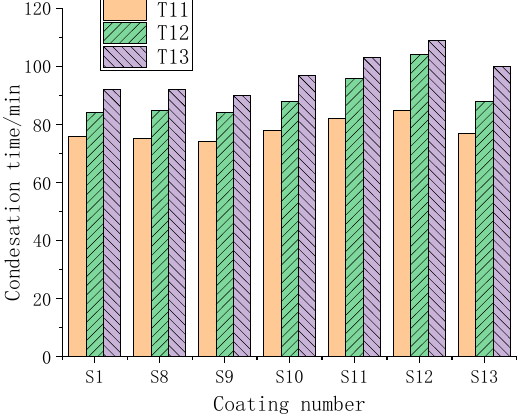
Figure 19. Different coating condensation times under three working conditions at 30 °C.